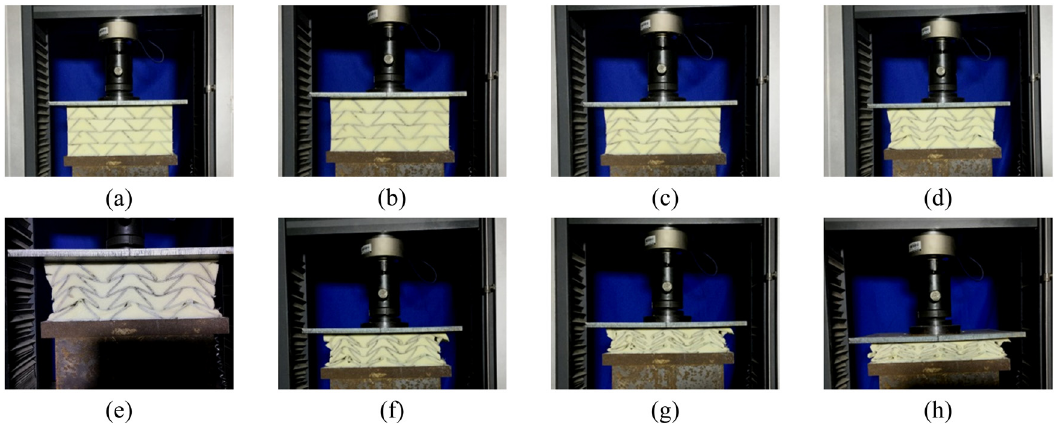
Figure 6: Quasi - static experiment of TS - T - A45: ( a ) beginning, ( b ) Δ = 15 mm, ( c ) Δ = 30 mm, ( d ) Δ = 45 mm, ( e ) Δ = 60 mm, ( f ) Δ = 75 mm, ( g ) Δ = 90 mm, ( h ) Δ = 105 mm.